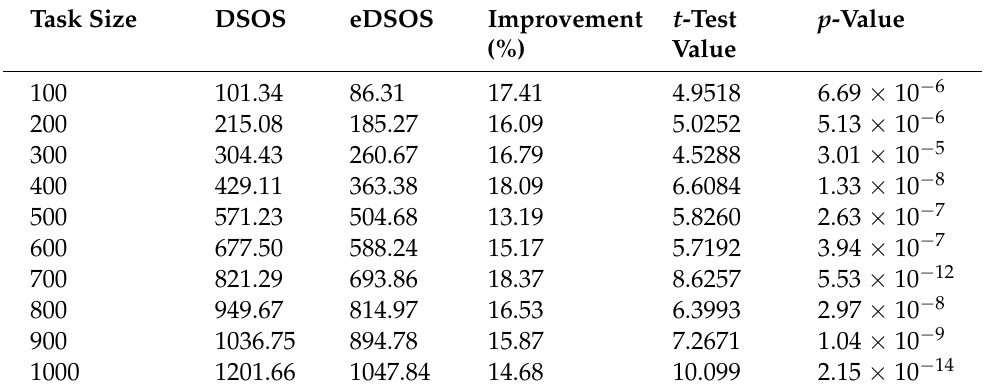
Table 6. Comparison of the makespans of DSOS and eDSOS for the dataset with the left-half distribution. Task